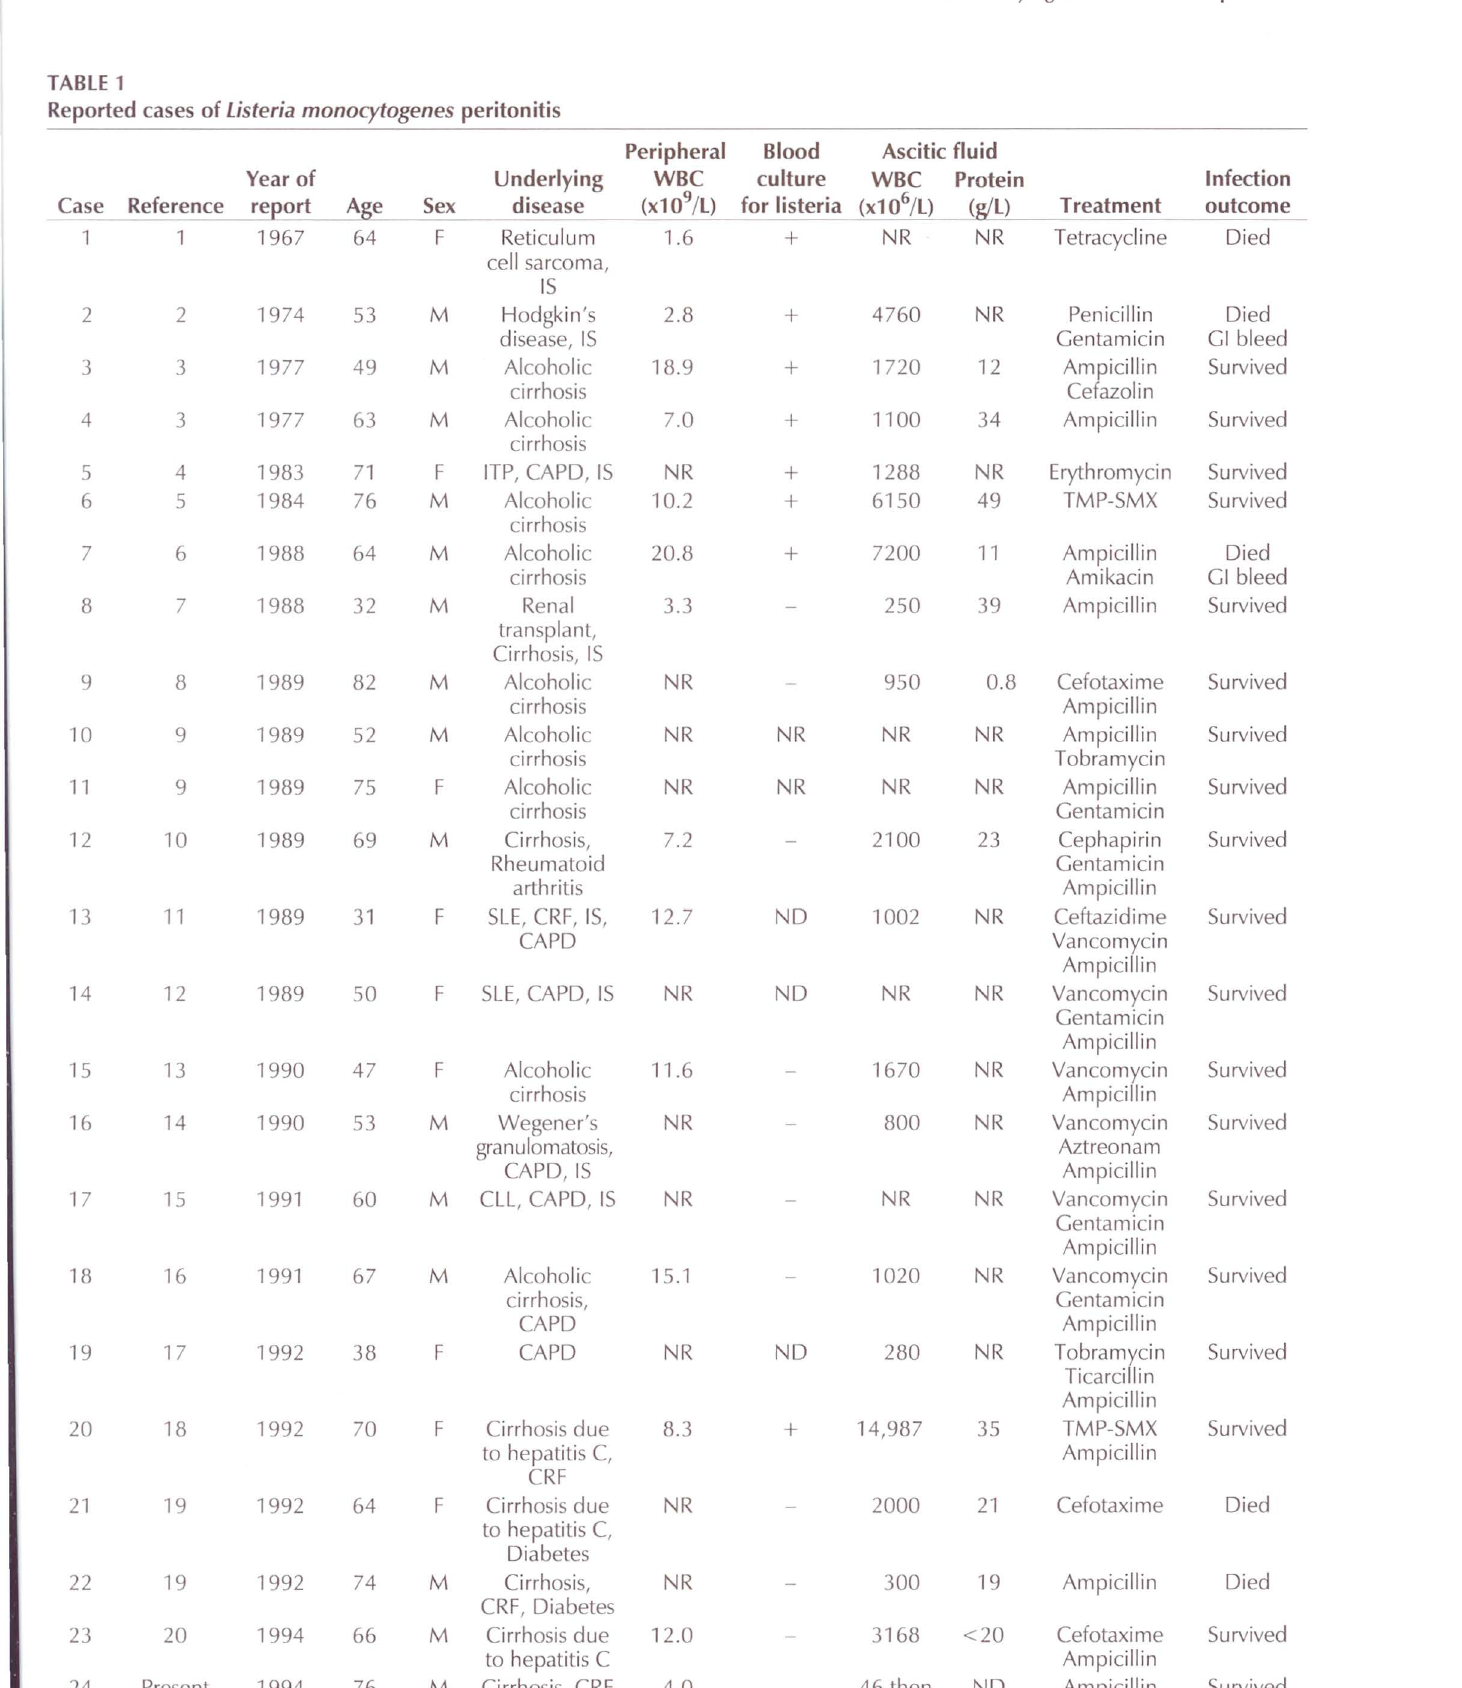
Reported cases of Listeria monocytogenes